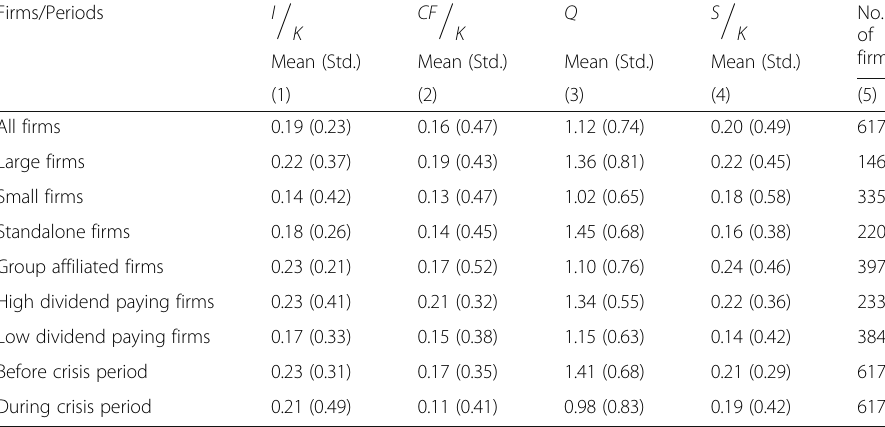
Table 4 Summary statistics of the key variables Firms/Periods